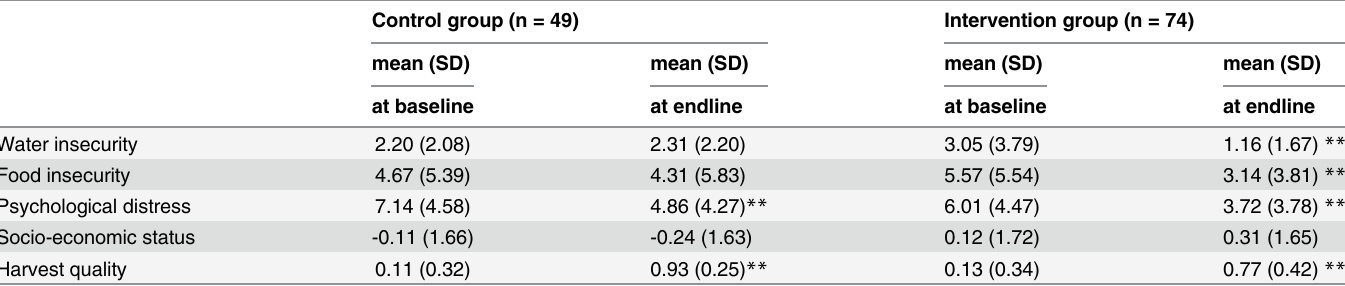
Table 2. Summary statistics for household food and water insecurity, socio-economic status, and women ’ s psychological distress: Baseline and endline measures in intervention and control villages in South Wello, Ethiopia (n =